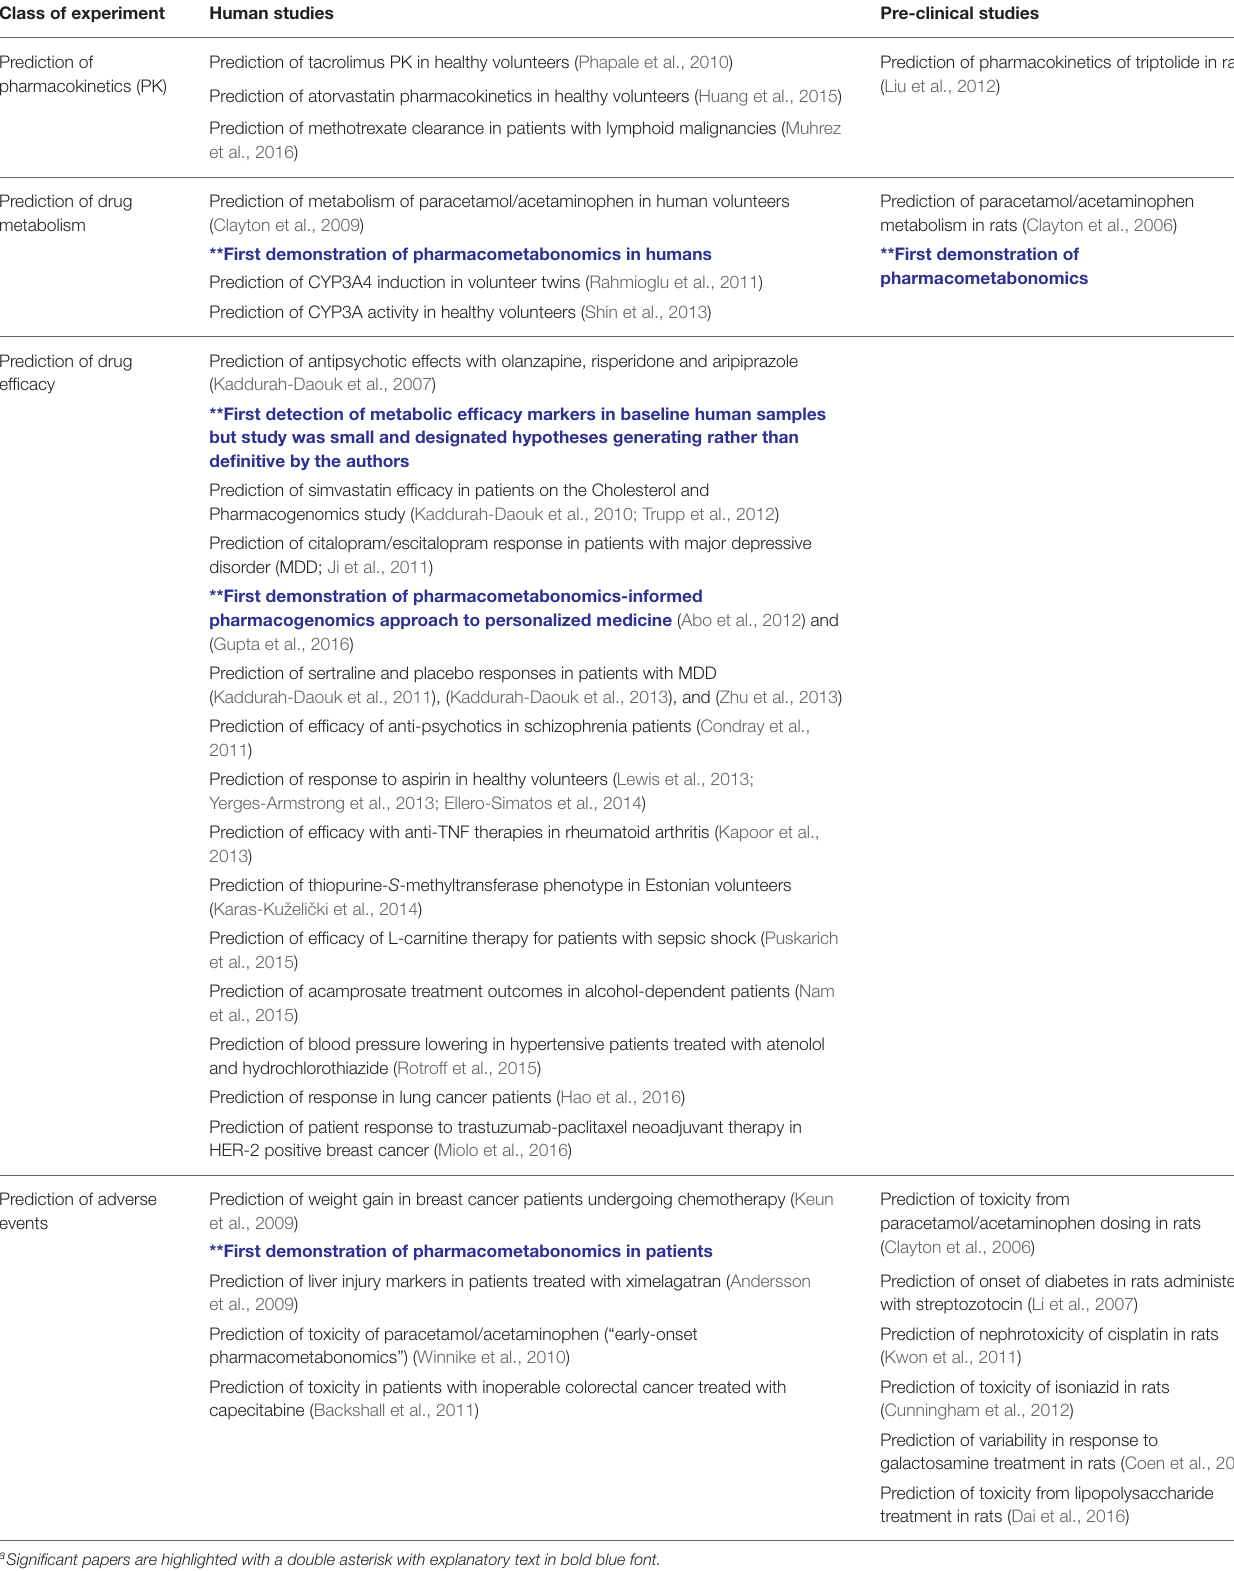
Frontiers in Pharmacology |